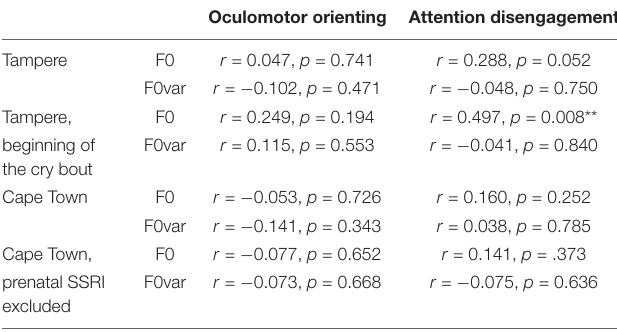
TABLE 2 | Correlations (Pearson’s r ) between the F0 parameters and attention outcomes in the two cohorts. Oculomotor orienting Attention